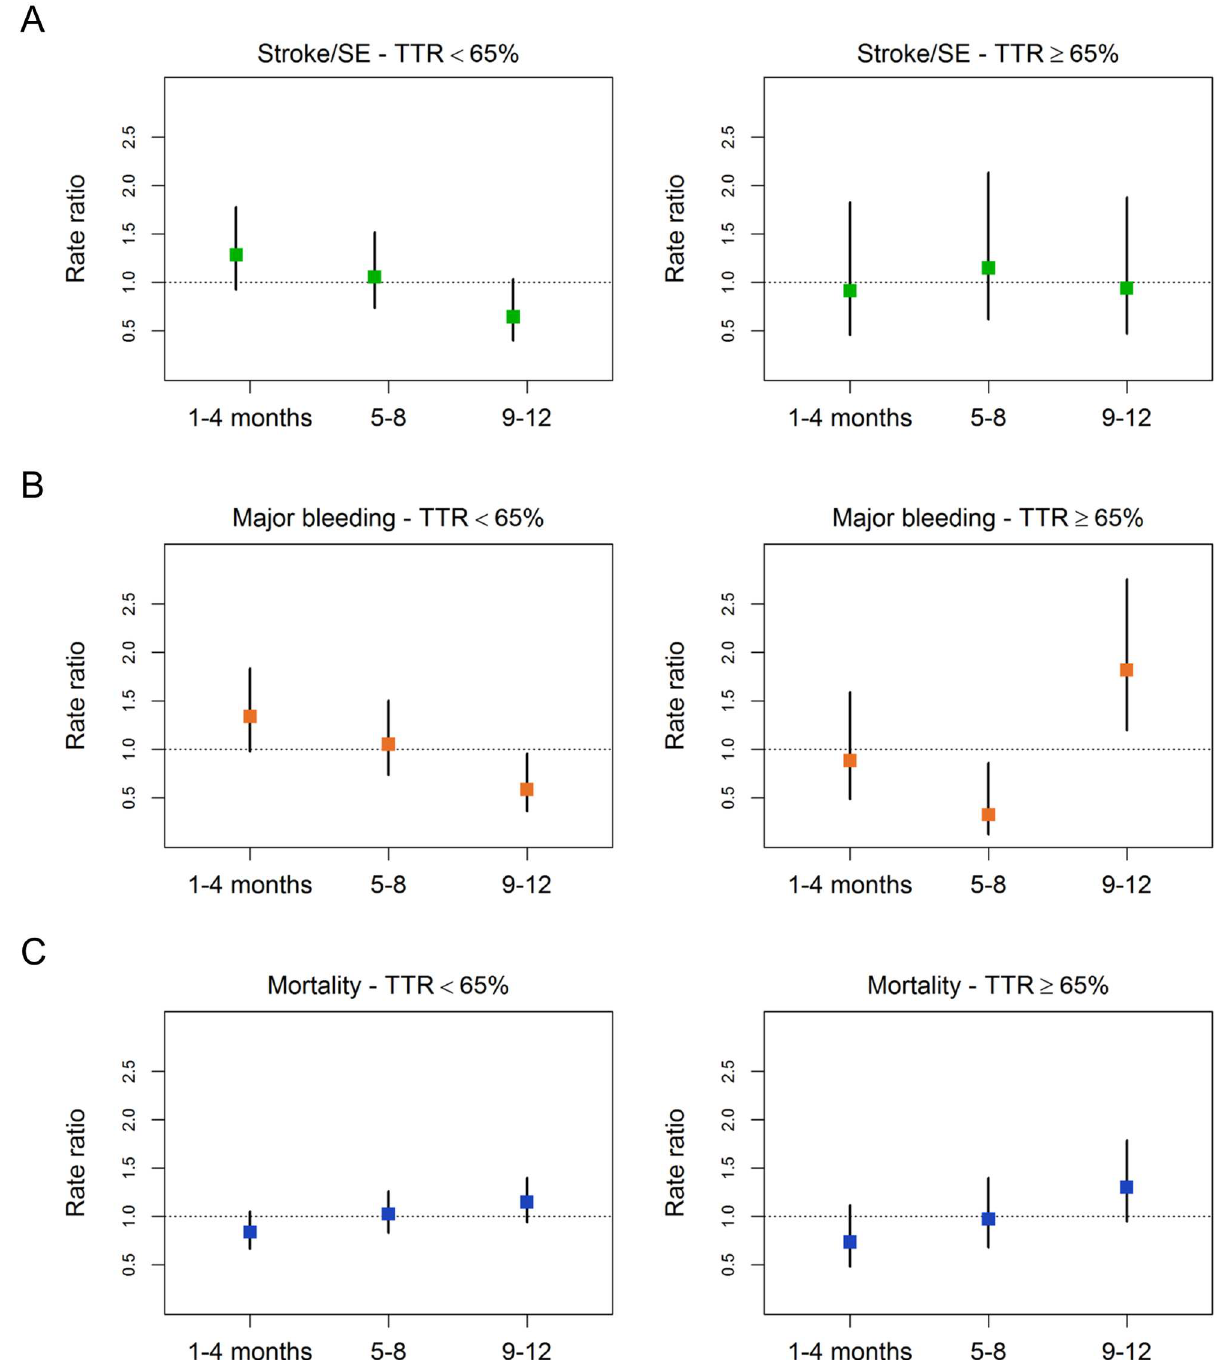
Fig 2. Four-month rate ratios by proportion of time in therapeutic range for (A) stroke/systemic embolism, (B) major bleeding, and (C) all-cause mortality. SE, systemic embolism; TTR, time in therapeutic range.